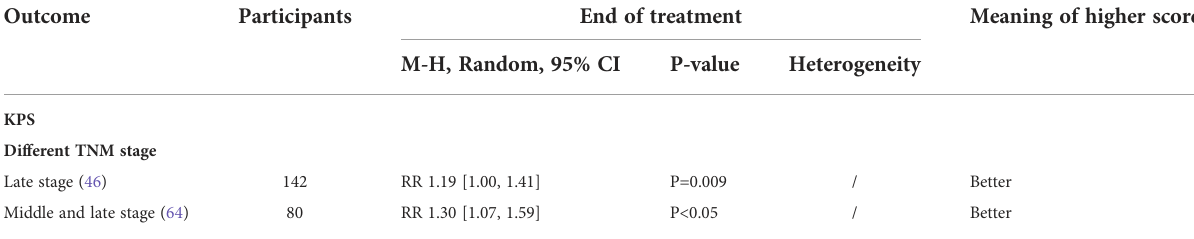
TABLE 2 The QOL of acupuncture with dichotomous variables versus comparators for lung cancer treatment – related symptoms.